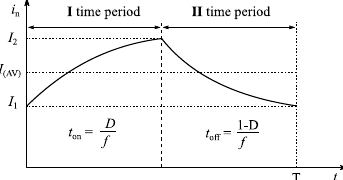
Figure 3. Current waveform in CCM of converters n leg.